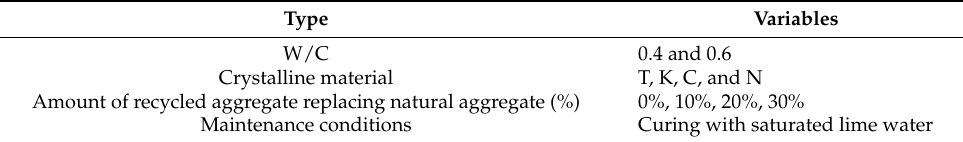
Table 4. Test variables.